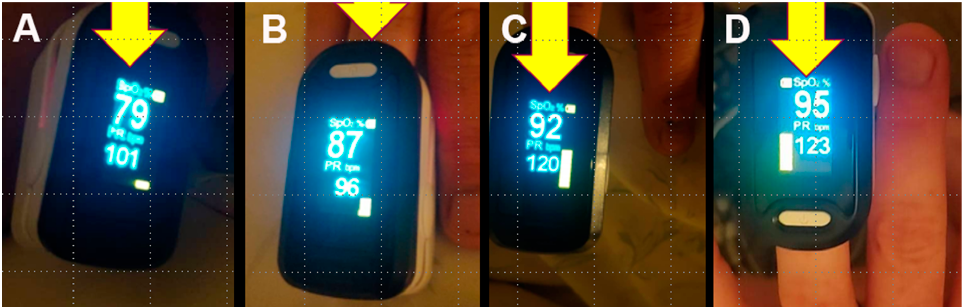
Figure 4. Changes in SpO2 over 3 h for a COVID-19 patient after administration of IVM. SpO2 values are shown (all on room air), with pulse rates (bpm) below those, at pre-treatment ( A ) and for 45 min ( B ), 90 min ( C ), and 3 h ( D ) after first dose of IVM. This patient, a 25-year-old male, was diagnosed with COVID-19 by a positive result from a rapid antigen test and treated with combination therapy including IVM, doxycycline, and zinc plus other oral and nebulized adjunct agents from among those itemized above.